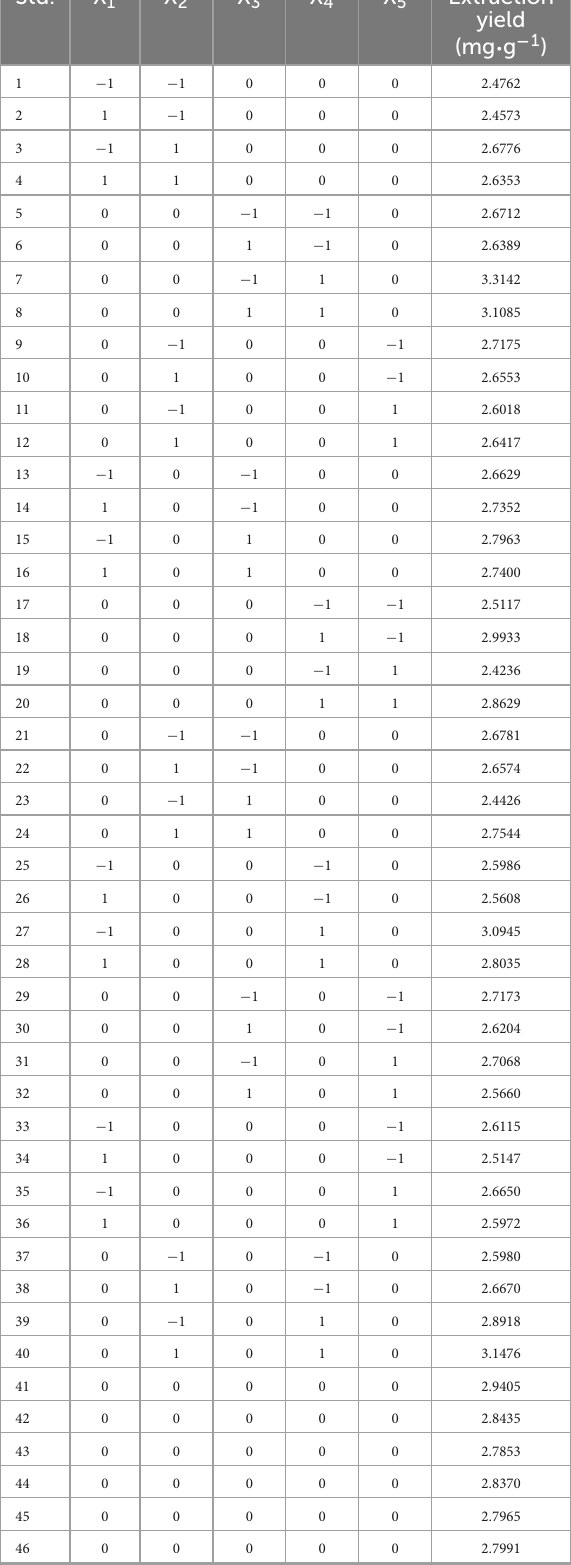
TABLE 4 Box-Behnken design (BBD) matrix and response values for the ellagic acid (EA) yield.